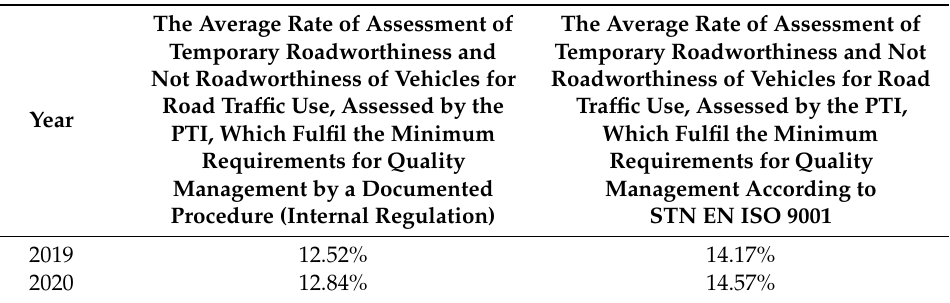
Table 2. Results of the evaluation of vehicles at PTI depending on the method of meeting the requirements for quality management; Source: Author according to [65].